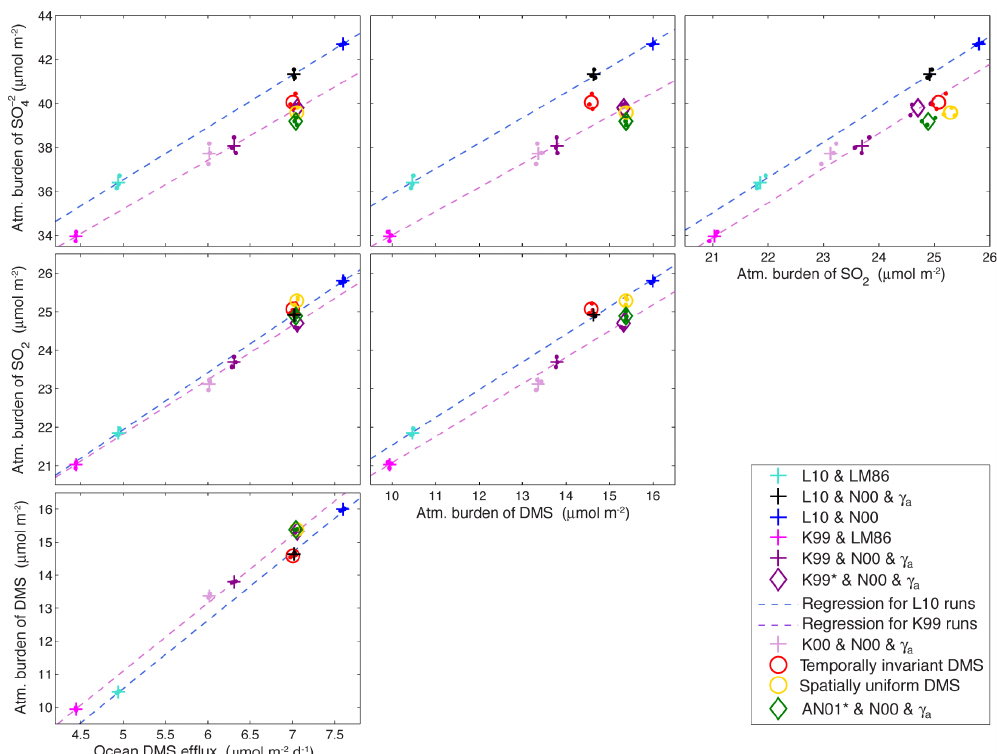
Figure 4. Scatter plots of atmospheric burdens of sulfur species vs. other species and ocean DMS emissions. Each dot represents the global and annual mean of individual ensemble members from the model experiments summarized in Table 1. Crosses indicate ensemble means for simulations with the original, unscaled flux fields. The regression lines were computed from the individual ensemble members corresponding to these unmodified DMS flux fields. Open circles denote ensemble mean of simulations with seasonality (red) or spatial pattern (yellow) removed. Open diamonds denote ensemble averages of simulations with DMS fields different from L10 but scaled to give the same global- mean flux. The first column shows atmospheric burdens of sulfur species (SO 2 − , SO 2 , DMS) against ocean emission of DMS, the second 4 column shows atmospheric burdens of SO 2 − and SO 2 against DMS burden, and the third column shows atmospheric burden of SO 2 − against 4 4 the SO 2